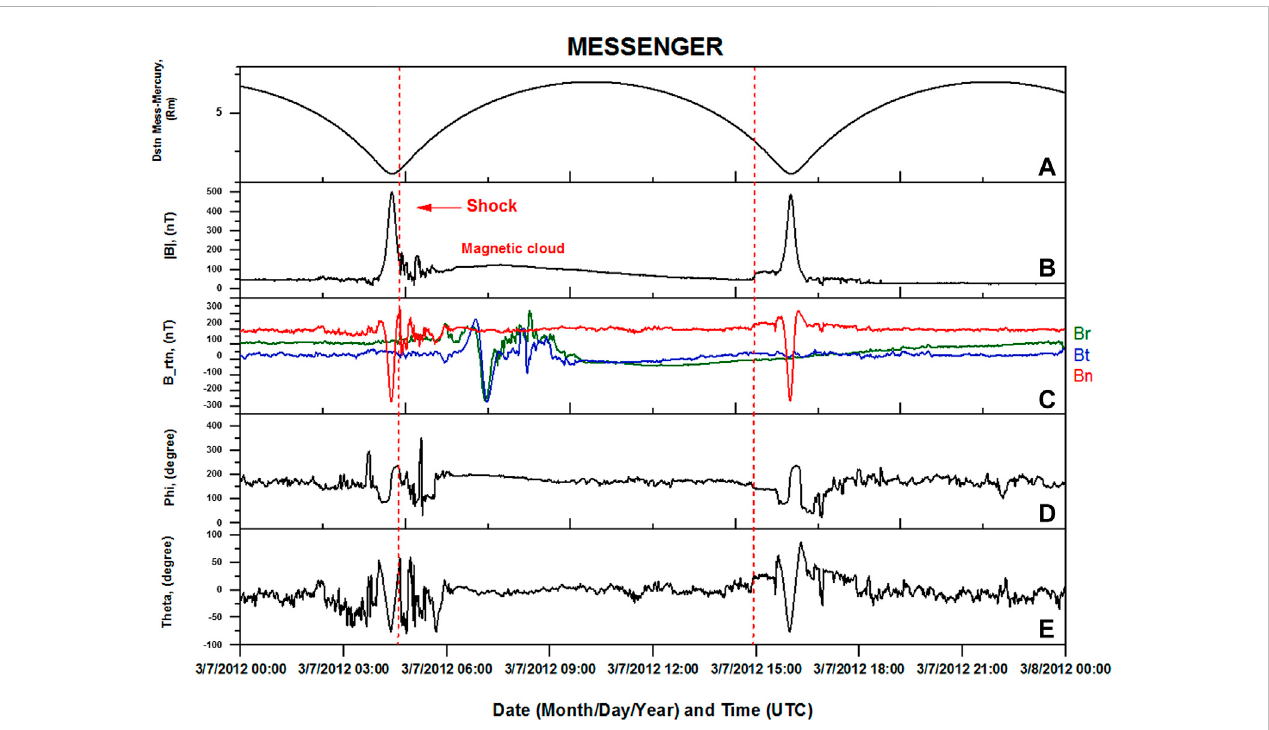
FIGURE 5 ICME signatures observed by MESSENGER during its orbit phase in March 2012. First vertical red dotted line depicts the arrival of shock. The distance of spacecraft from the Mercury surface is shown in (A) . Panels (B) and (C) show the total magnetic fi eld and its components (R, N, T coordinates), respectively. Panels (D) and (E) show the phi and theta components,